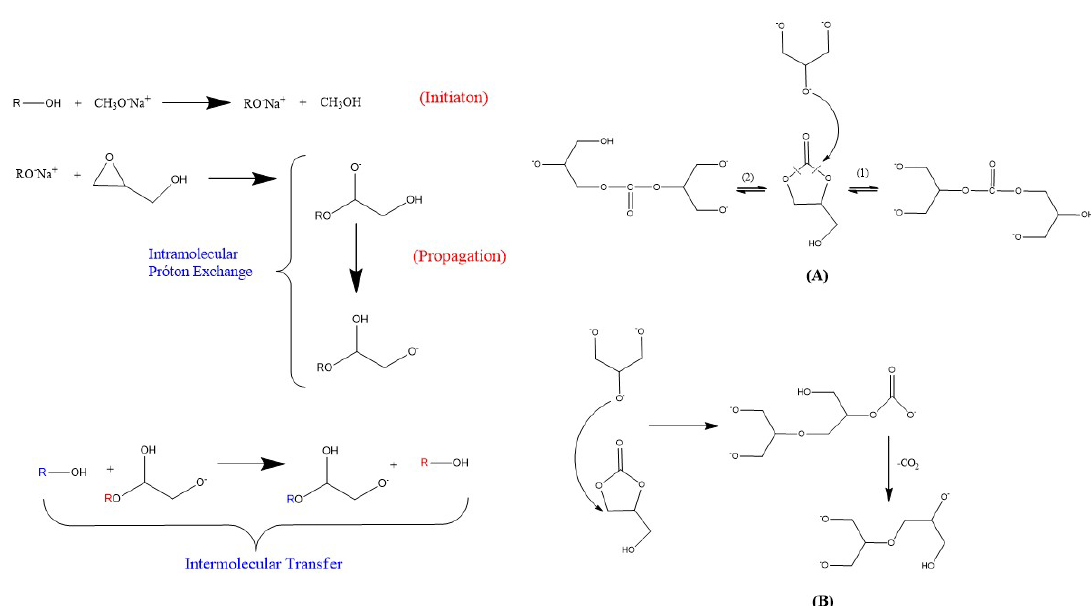
-type monomer (glycidol). (a) Carbonyl carbon atom attacked. (b) Alkyl 2